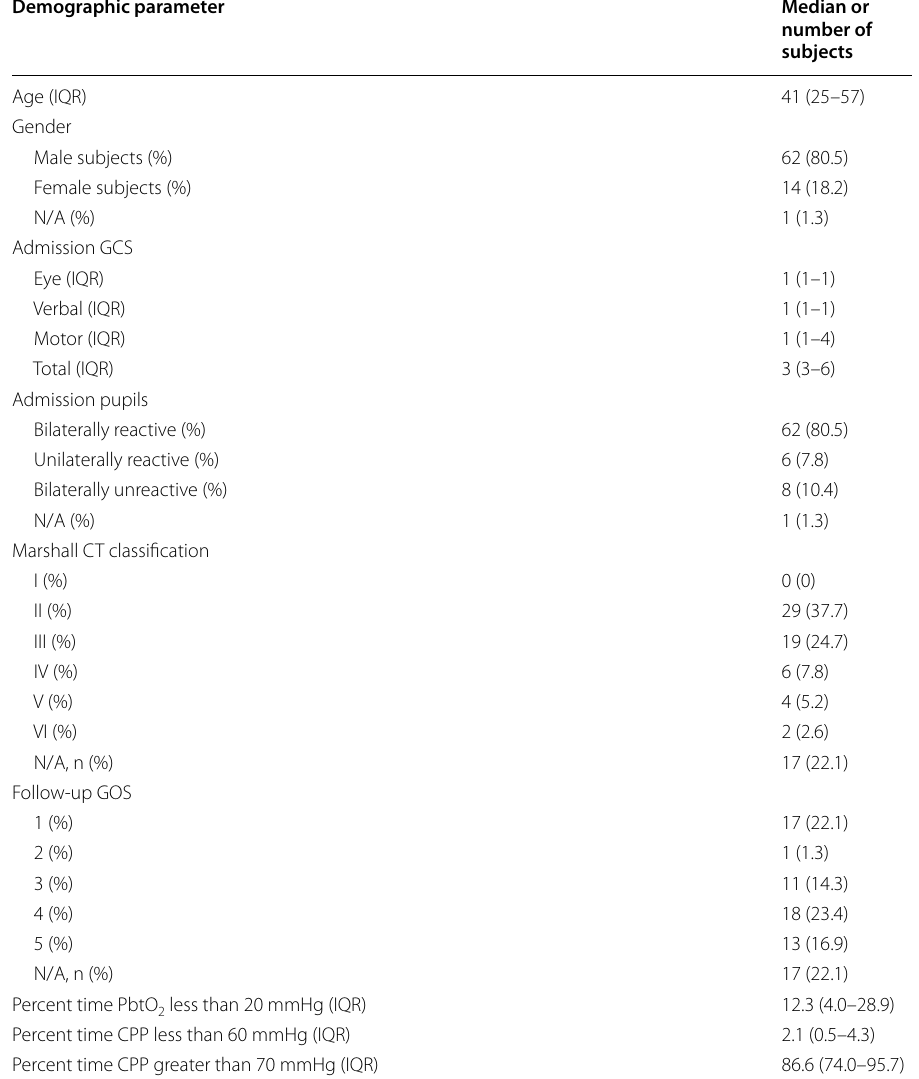
Table 1 Patient demographics for the